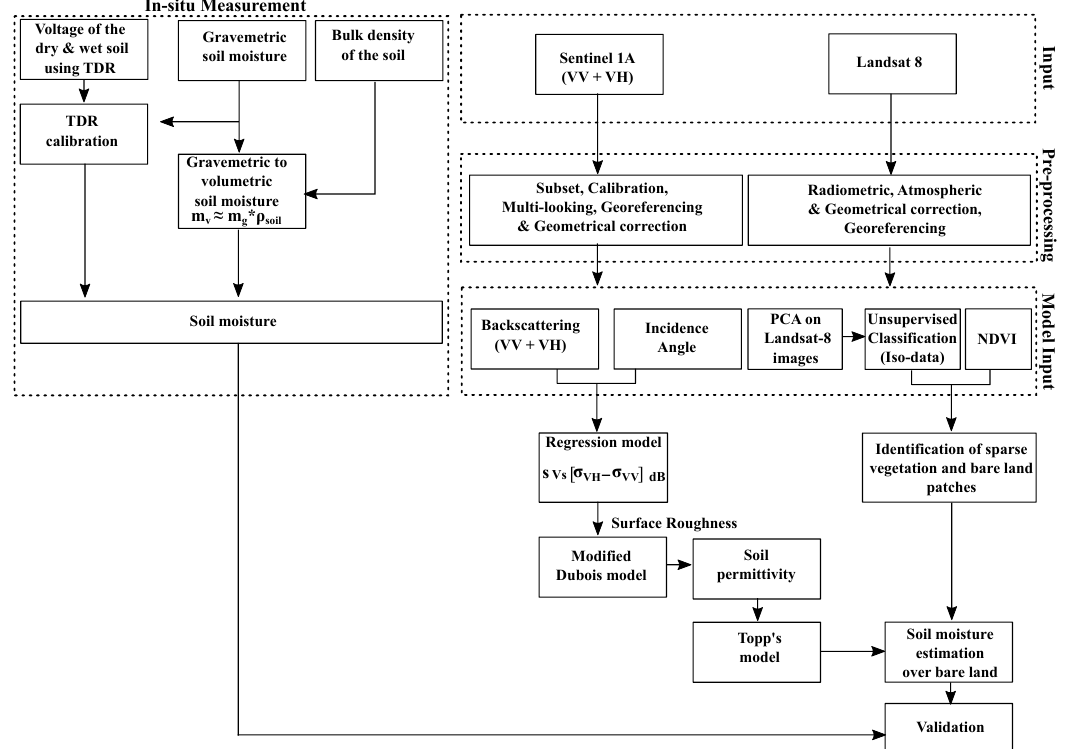
Figure 4. Flow chart illustrates the methodology used for the estimation of soil moisture from Sentinel-1